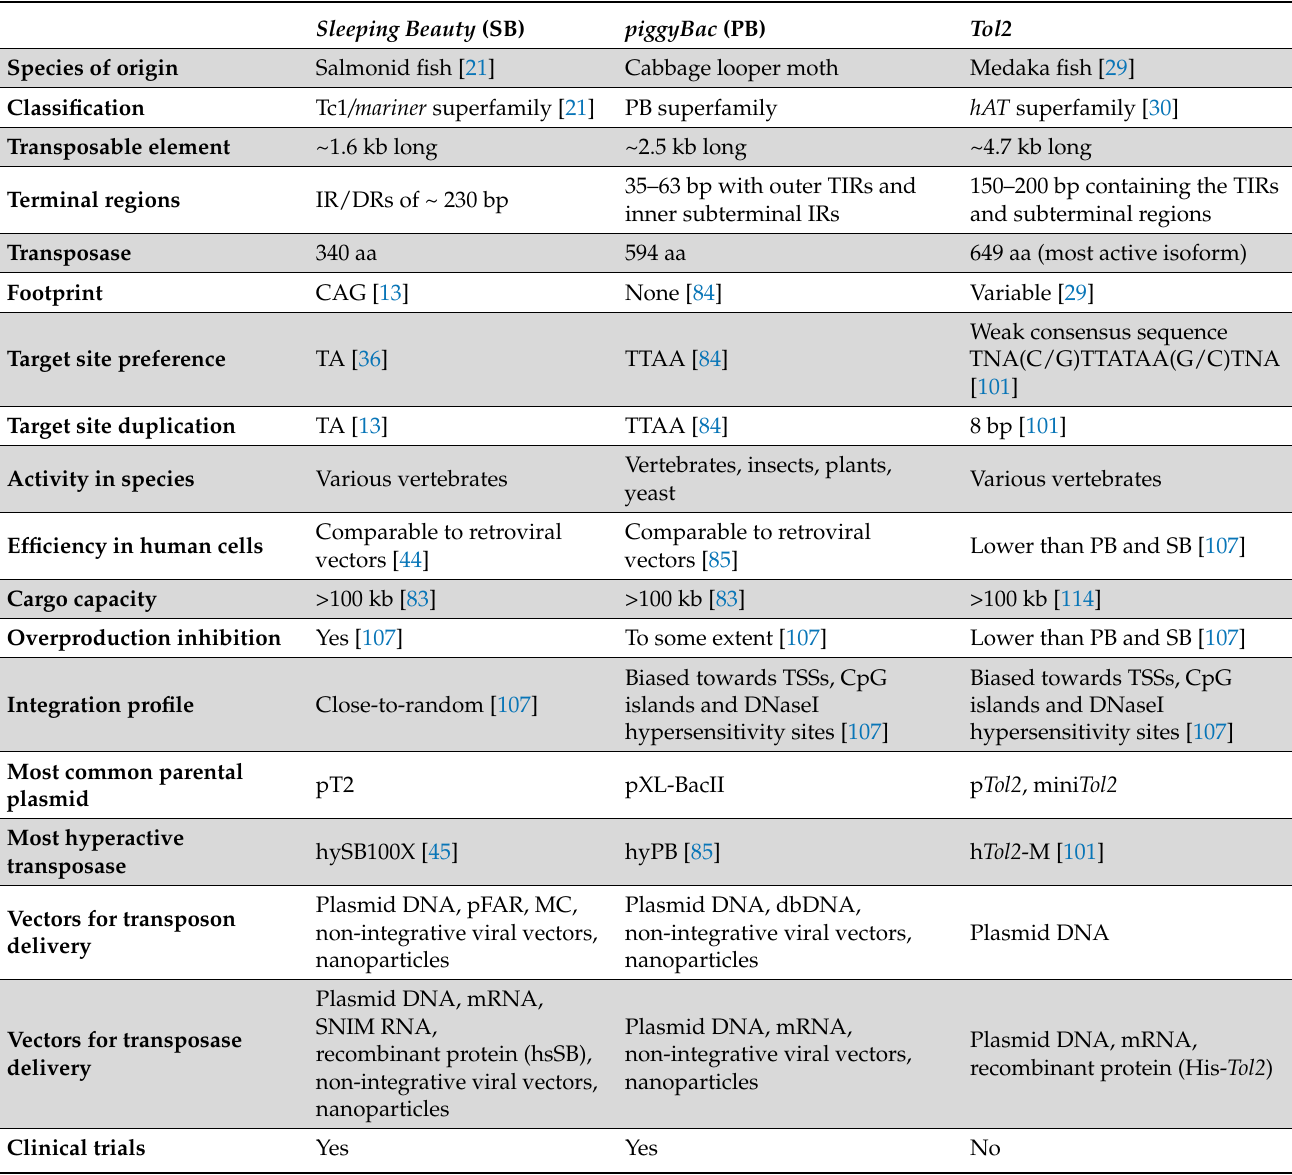
Table 1. Comparison of Sleeping Beauty , piggyBac, and Tol2 characteristics, associated technologies and